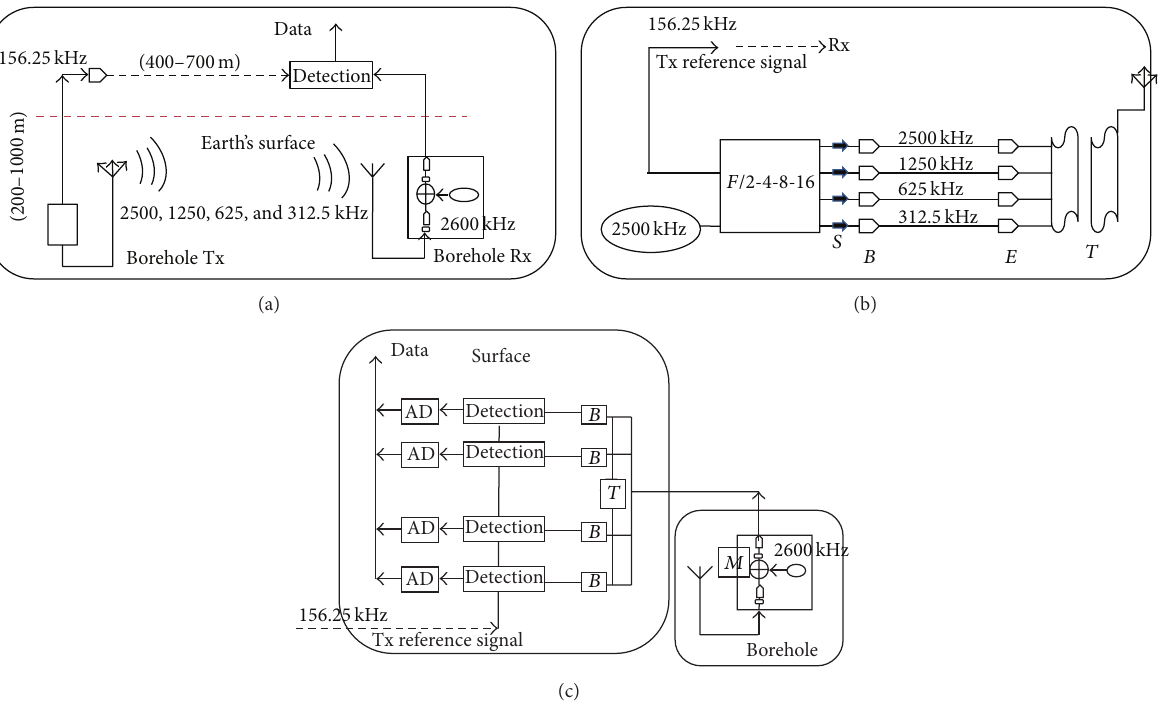
Figure 5: Diagrams of (a) the EMRE system, (b) the transmitter, and (c) the receiver.